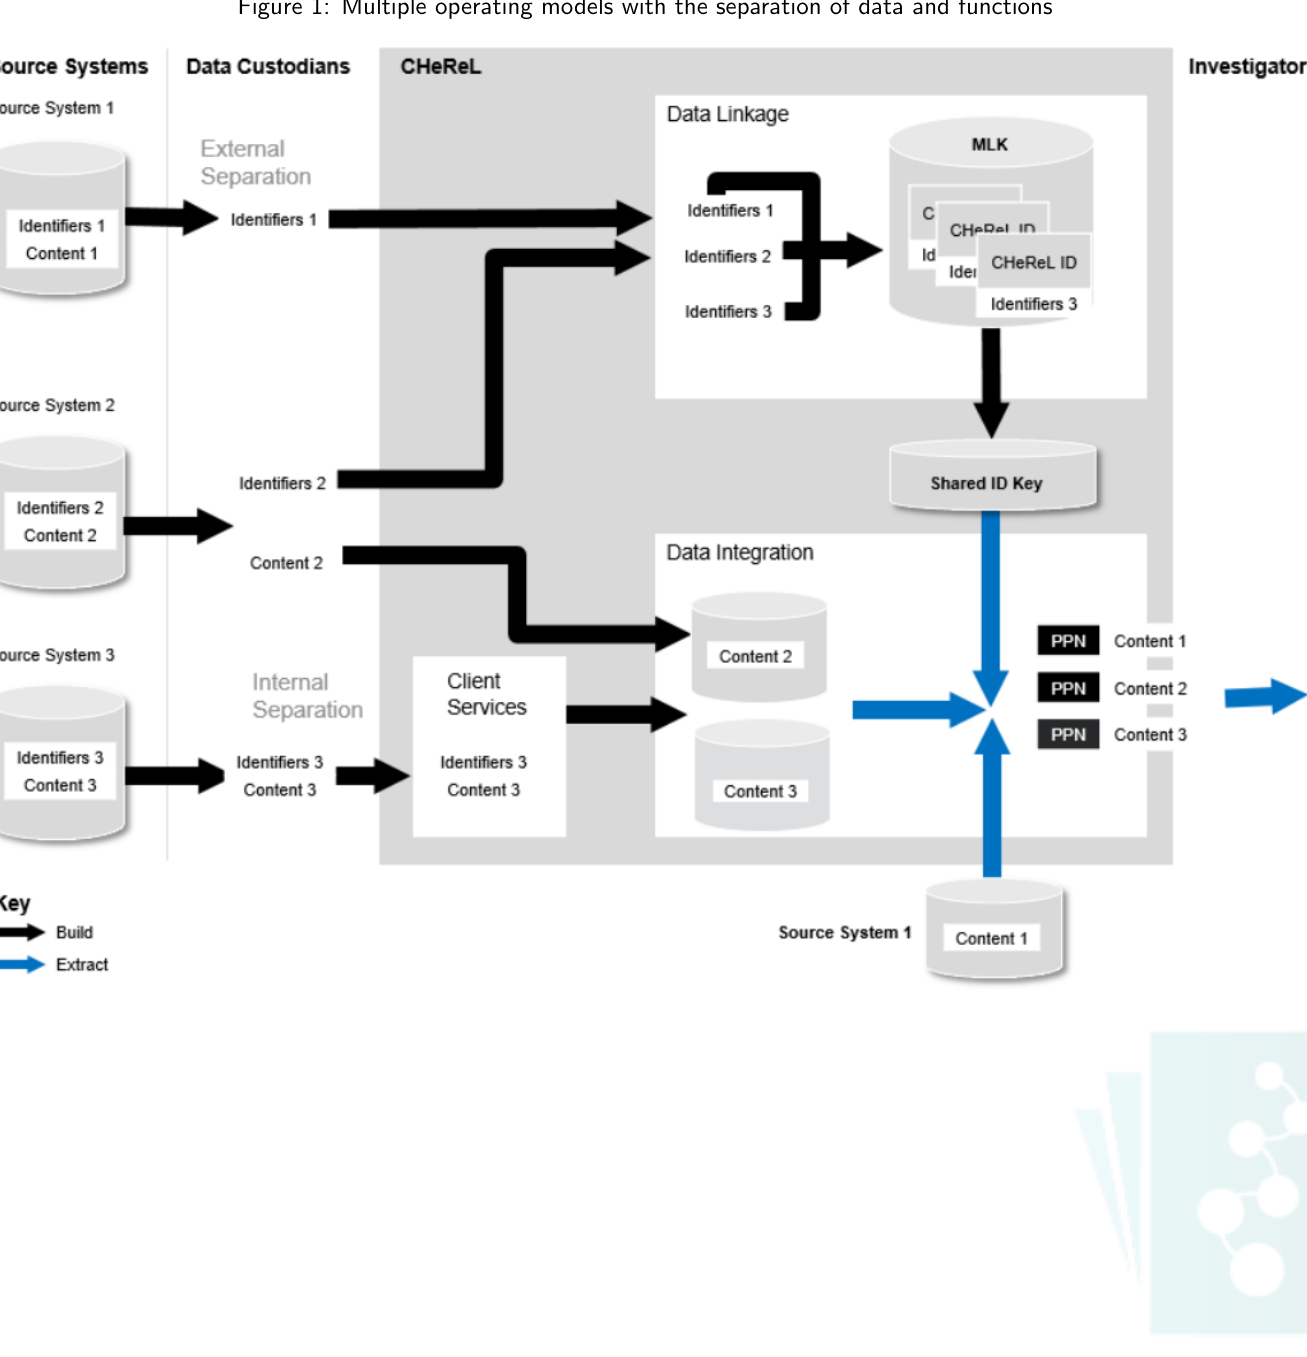
Figure 1: Multiple operating models with the separation of data and